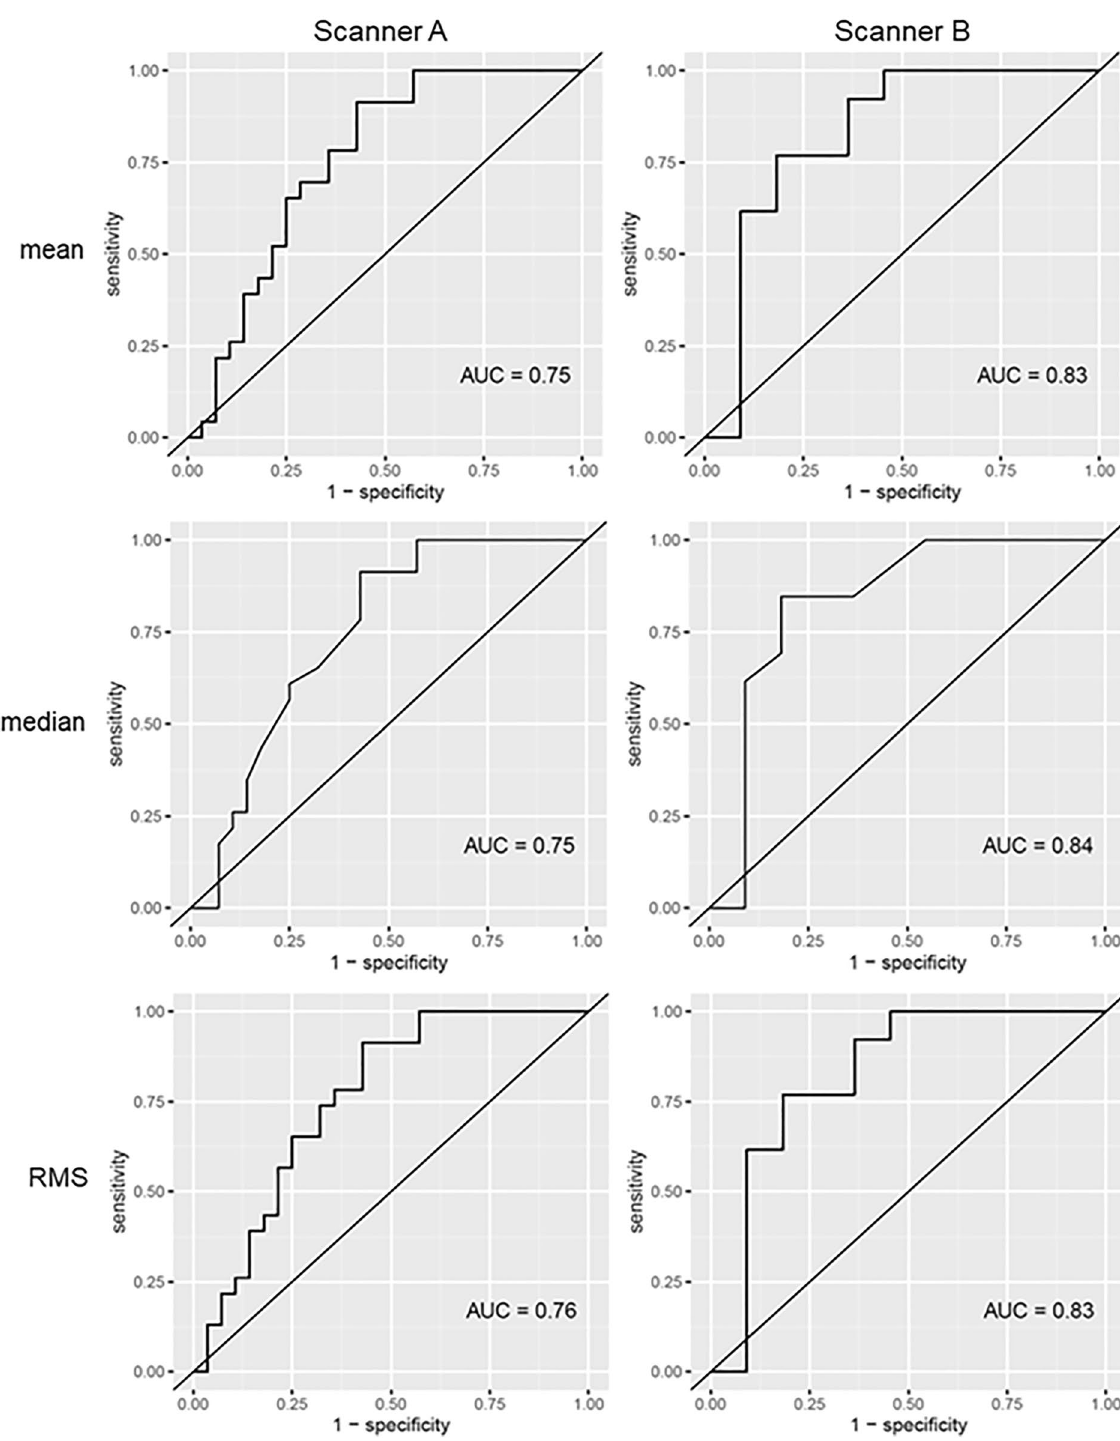
Figure 2. ROC curves of the three first-order features mean, median, and root mean squared (RMS), that concordantly distinguished Deauville score 4-positive and -negative lymphoma manifestations on both scanners. Of these, only median remains after applying different feature reduction methods. The left row shows the AUCs of Scanner A, and the right row the AUCs of Scanner